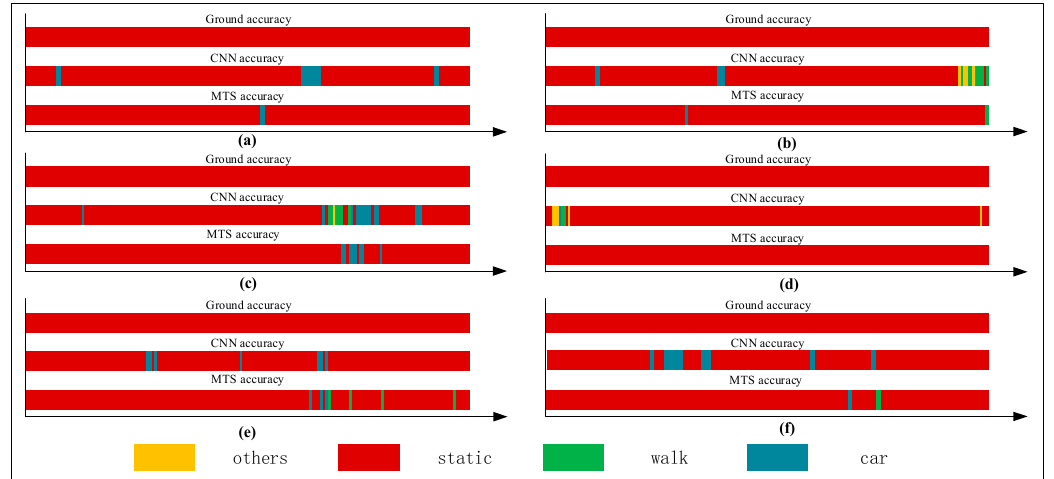
Figure 12. Graphs showing recognition of the other states.